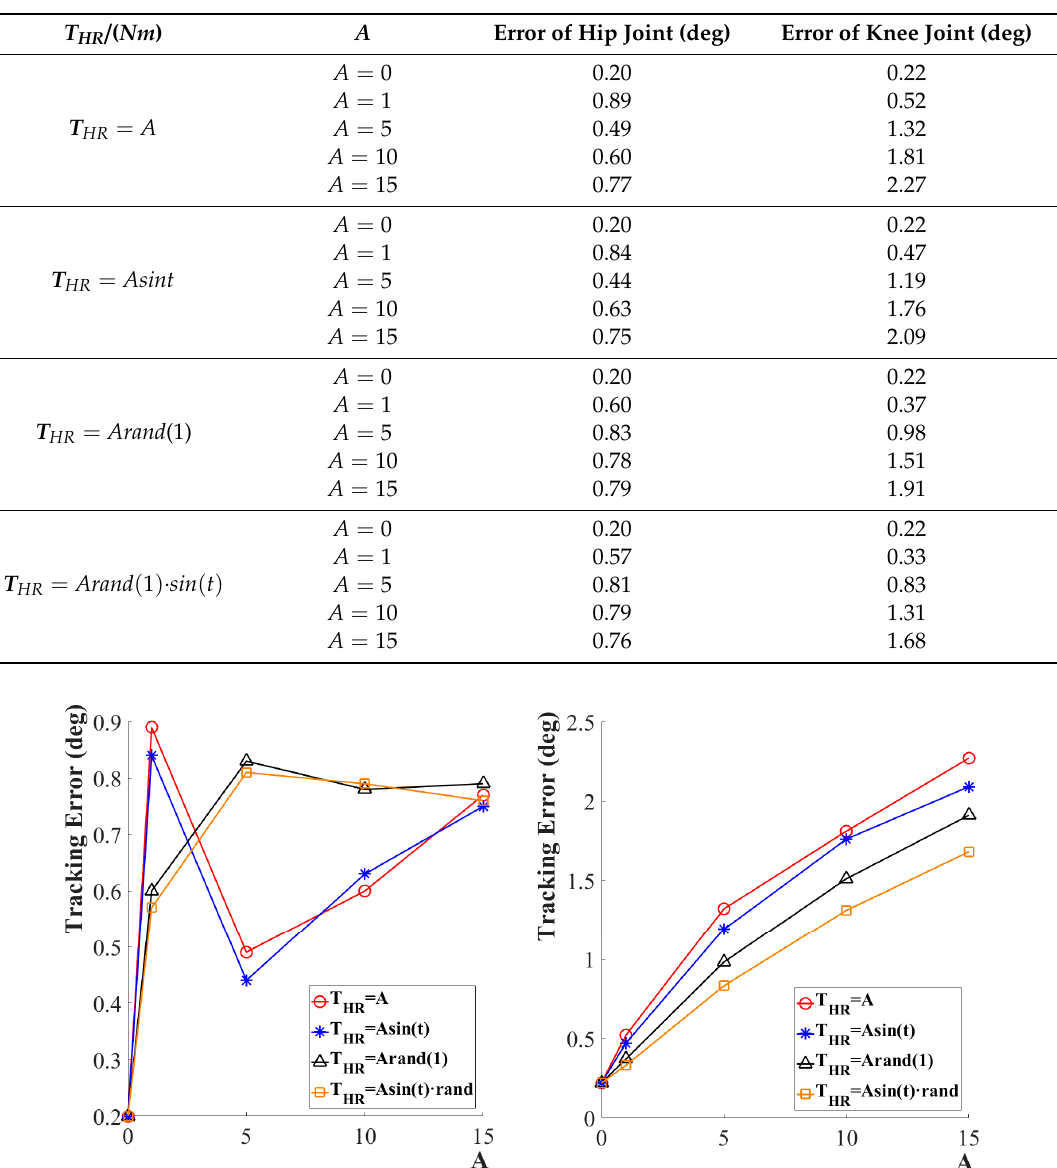
Figure 10. The impact of T HR on trajectory tracking of the hip joint ( left ) and the knee ( right ) joint